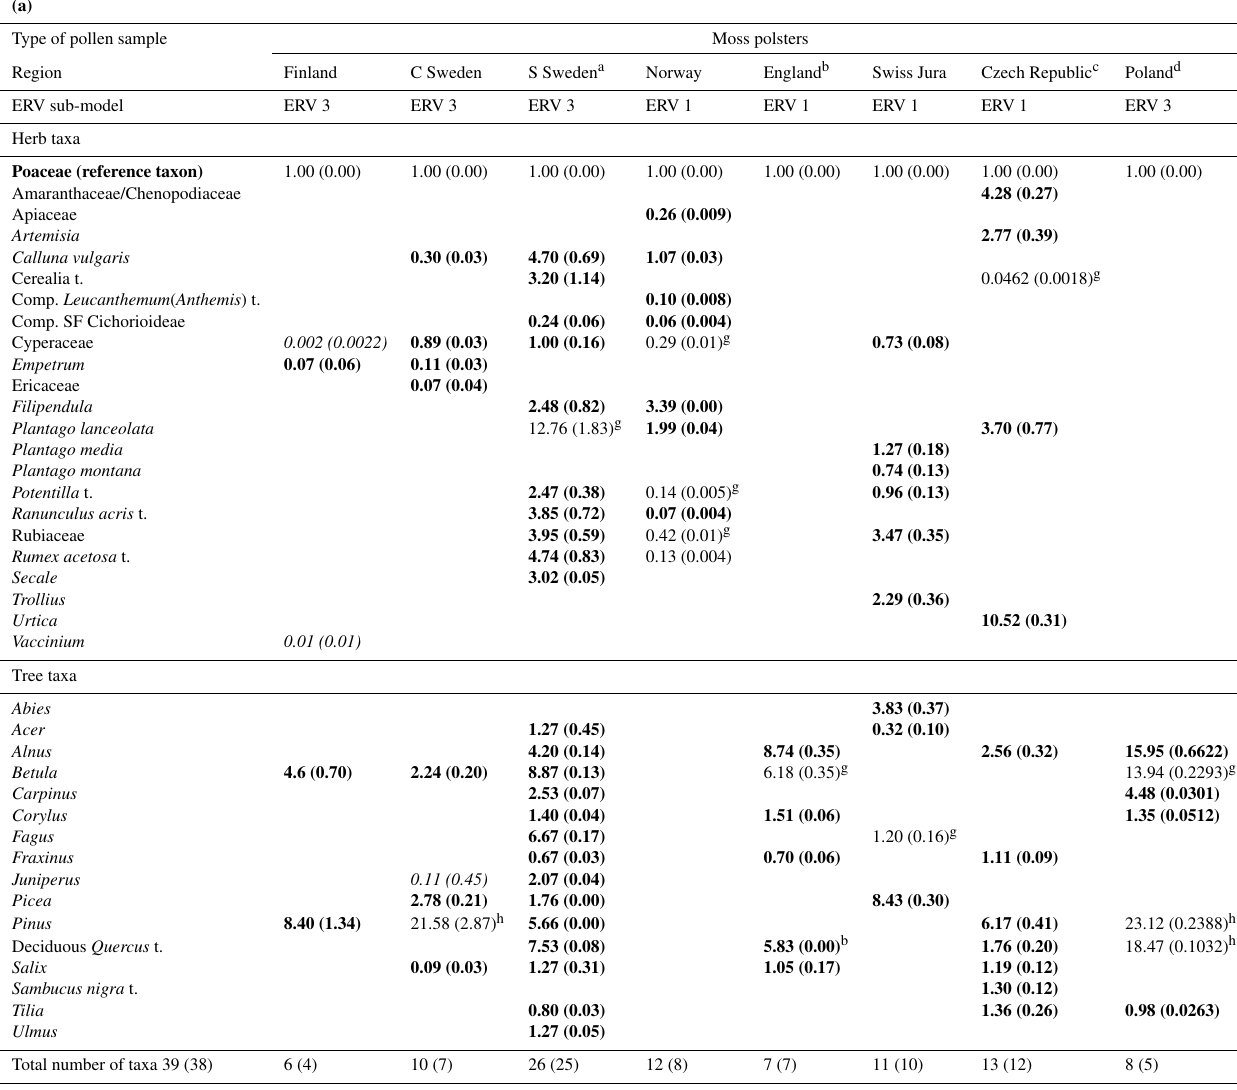
Table B1. Europe (Mediterranean area excluded): RPP estimates and their SDs (in brackets) with the total number of taxa per study indicated and in brackets the number of taxa with selected RPP estimates (in bold). (a) Studies using moss pollsters as pollen samples. (b) Studies using surface lake sediments as pollen samples. Abbreviations: t. – type, C – central, Comp. – Compositae (Asteraceae), ERV 1 and 3 – extended R value model sub-models 1 and 3, Medit. – Mediterranean region, Rep – Republic, S – southern, SF – subfamily. a RPPs for herbs from Broström et al. (2004); RPPs for trees from Sugita et al. (1999) (reference taxon Juniperus ) converted to Poaceae as reference taxon by Broström et al. (2004). b Bunting et al. (2005), reference taxon Quercus and no RPP for Poaceae; RPPs relative to Poaceae calculated by Mazier et al. (2012) assuming that the RPP of Quercus relative to Poaceae is the same as the mean RPP of Quercus from three other studies in NW Europe. c New RPPs from the Czech Republic (Abraham and Kozáková, 2012). d New RPPs from Poland. Poaceae as reference taxa (see text for more details). e New RPPs from Germany (Matthias et al., 2012), reference taxon Pinus . RPPs converted to Poaceae as reference taxon. We selected the RPP estimates obtained with the dataset of vegetation cover including only the trees that had reached their flowering age (allFIDage) (for more information, see Matthias et al., 2012). f New RPPs from Germany (Theuerkauf et al., 2012); in the original publication, the ERV analysis was performed with the Lagrangian stochastic model (LSM) for dispersal of pollen and with Pinus as reference taxon. For this synthesis, Martin Theuerkauf redid the analysis with the Gaussian plume model for dispersal of pollen (Parsons and Prentice, 1981; Prentice and Parsons, 1983) and with Poaceae as reference taxon. In bold: selected RPP estimates for calculation of the mean RPP values. g RPP estimates excluded because of too large of a difference with the other available estimates and their mean (less than half or more than double the mean RPP). h RPP estimates excluded due to their extremely high value compared to the other available estimates (much over double the mean of the other RPPs), i.e. from the study at Bialowice Forest (Poland; Baker et al., 2016) for Betula , Pinus and Quercus ; central Sweden (von Stedingk et al., 2008) for Pinus ; and Germany (Theuerkauf et al., 2013) for Betula , Quercus , Tilia and Ulmus . Values in italic: RPP estimates excluded because SD ≥